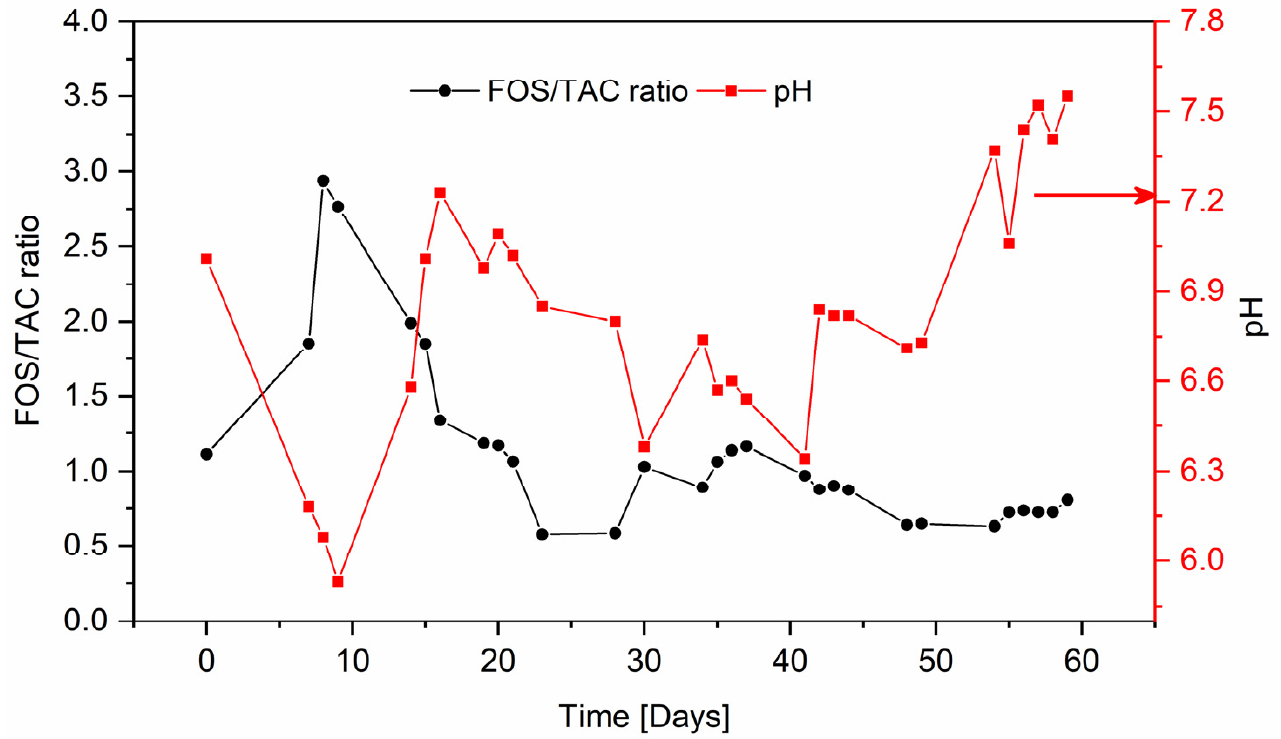
Figure 3. Variation of pH and FOS/TAC ratio during the AD.